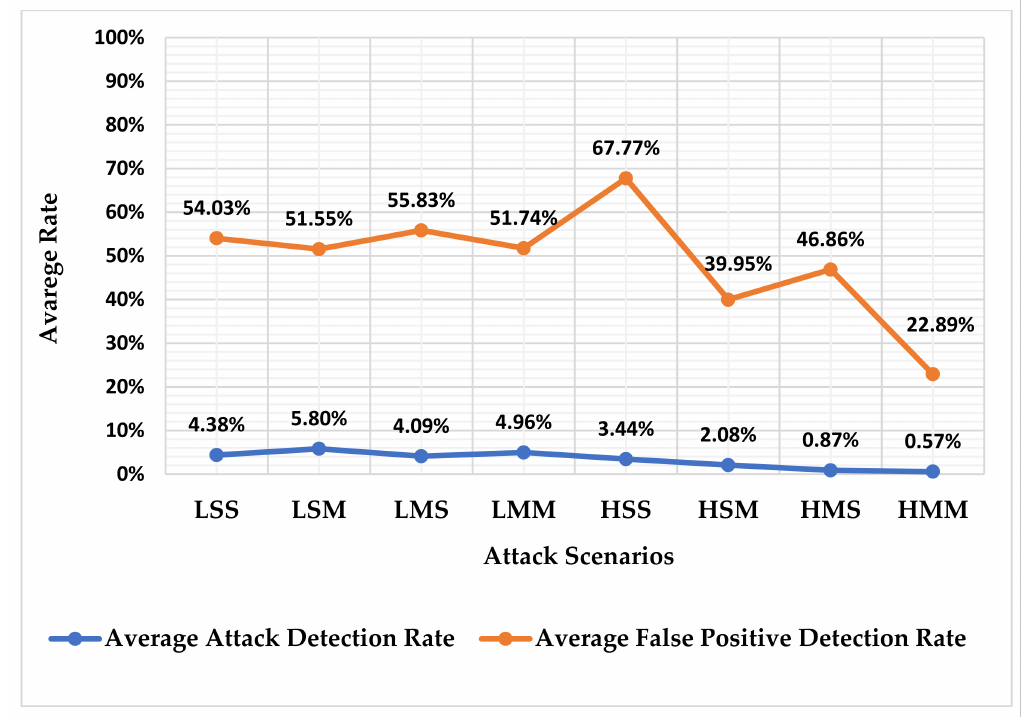
Figure 7. Average enhancement of proposed approach compared with fusion entropy method using all simulation scenarios.